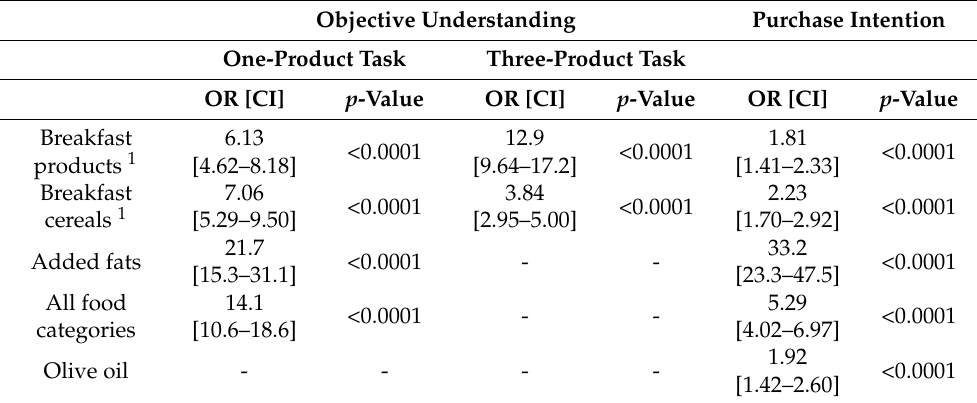
Table 3. Associations between Nutri-Score and the capacity to identify the most nutritionally